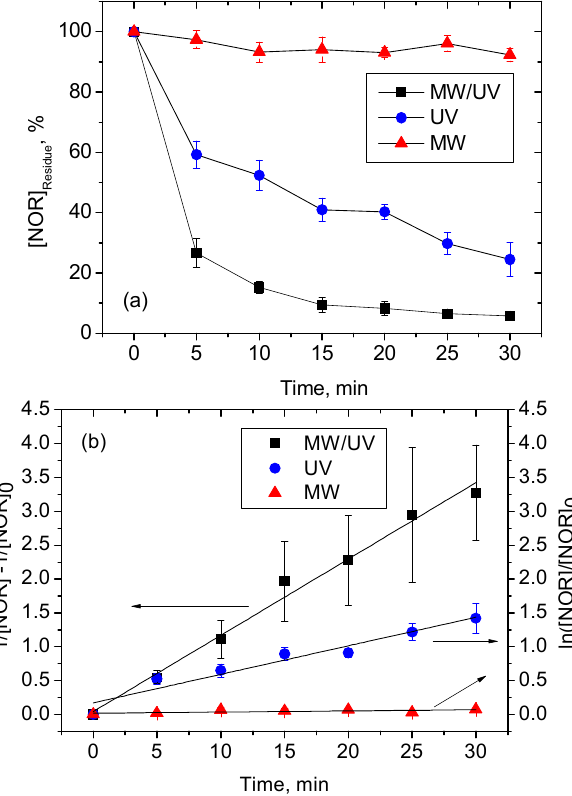
Figure 1. ( a ) Degradation of NOR with time by different processes and ( b ) kinetics analysis of the results obtained in ( a ). (Experimental conditions: microwave power = 500 W, UV light intensity = 31.8 mW/cm 2 , maximum wavelength = 254 nm, [NOR] = 5 mg/L, and pH =